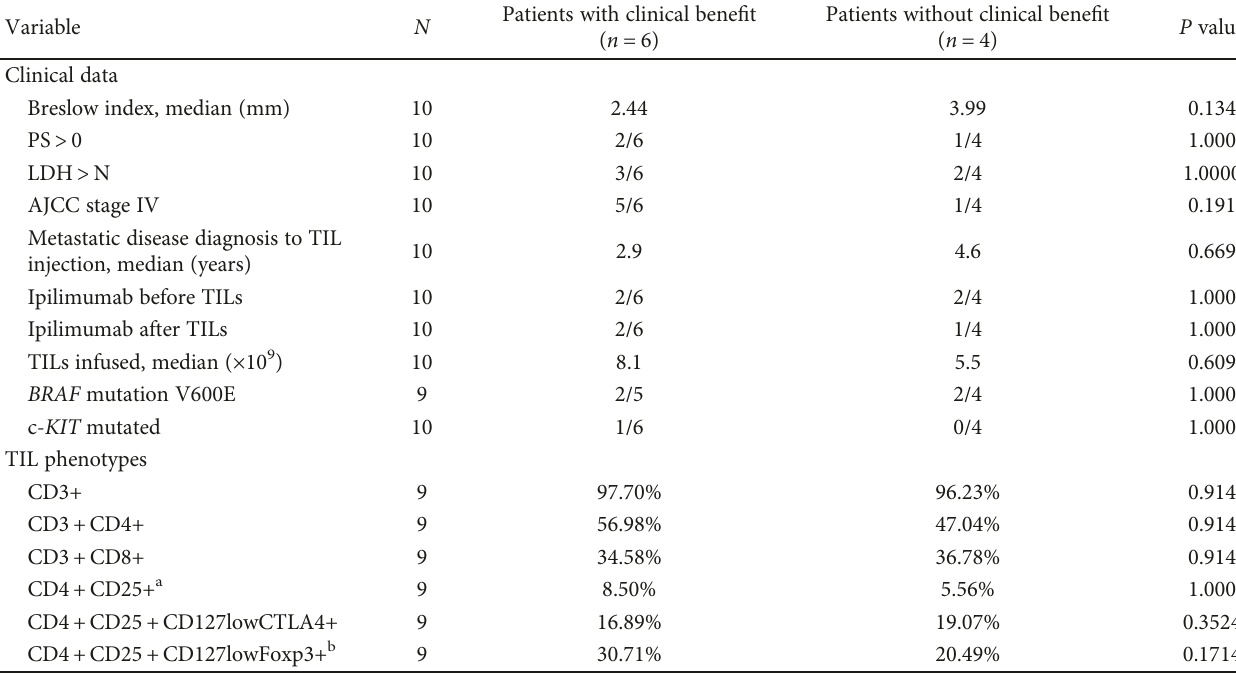
Table 3: Comparisons of characteristics between patients with clinical bene fi t (CR, PR, and SD) and patients without clinical bene fi t (PD).